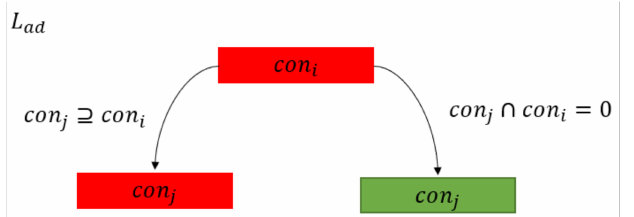
Figure 7. Transmission Relationship of Usage Authority. Blacklisting